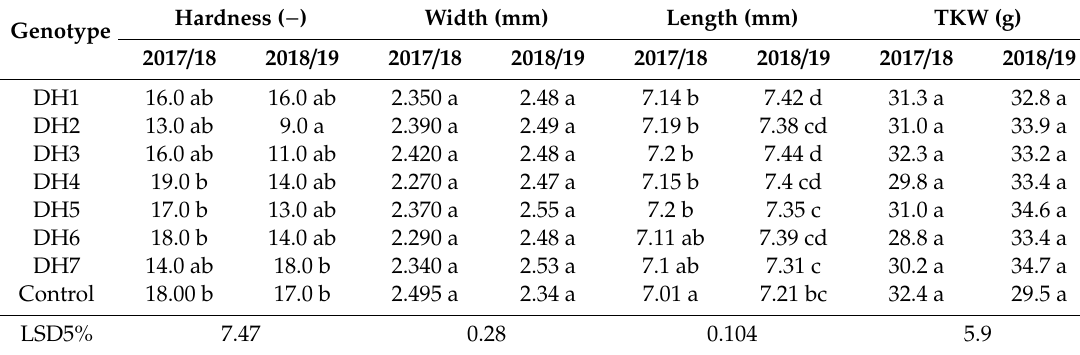
Table 12. Values of grain physical parameters of ‘Tonkoly.pop1’ spelt wheat advanced line (Control) and its doubled haploid (DH) lines based on field experiments. Values with the same capital letters are not significantly di ff erent ( p >